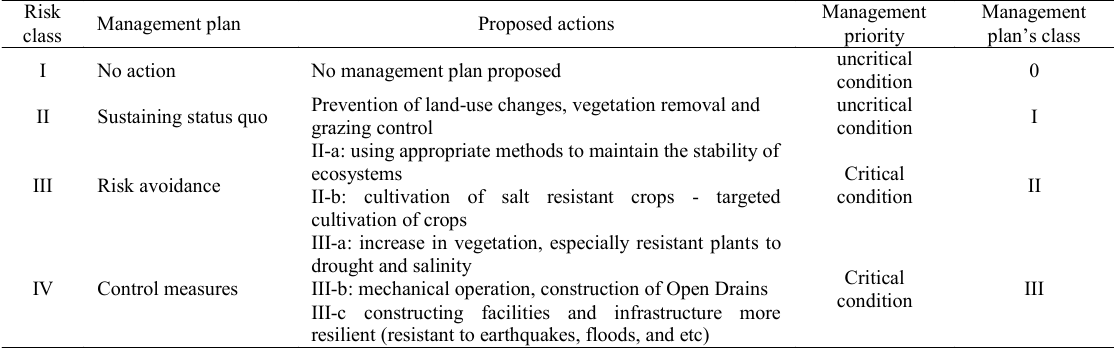
Table 8: A guide to setting priorities in management plans (Adopted from Ownegh, 2009 with a slight modification based on the UNEP’s strategy)